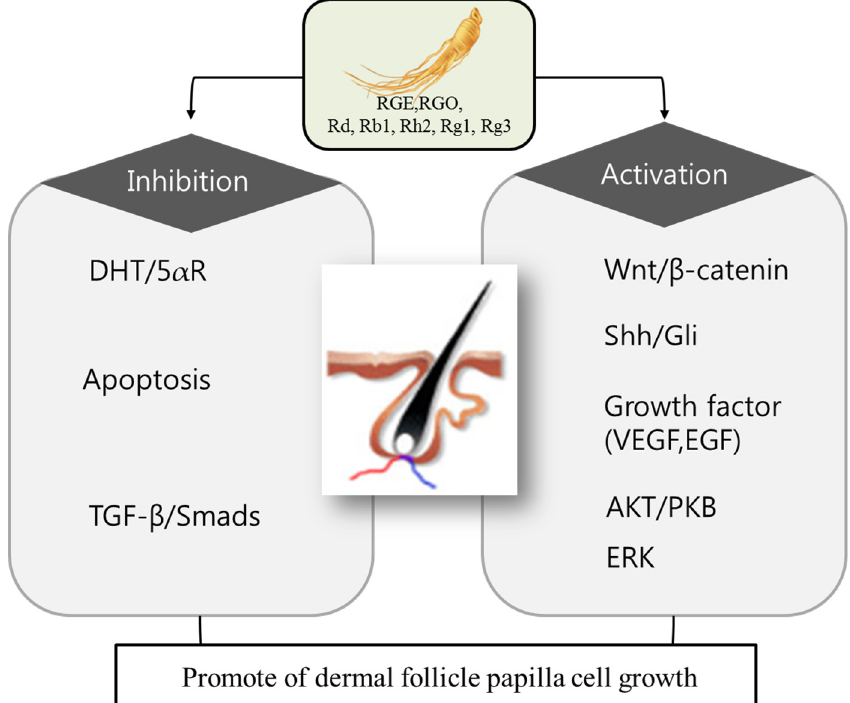
Figure 1. Potential molecular targets of ginseng in hair growth and loss. Ginseng exhibits therapeutic potential for hair growth and preventing hair loss by preventing the apoptosis of dermal follicle papilla cells. Ginseng components: RGE (red ginseng extract), RGO (red ginseng oil), ginsenoside Rd, Rb1, Rh2, Rg1, Rg3. antiandrogenic: DHT (dihydrotestosterone), 5-aR (5α-reductase). Apoptosis inhibition: TGF- β (transforming growth factor beta), Smads (homologues of the Drosophila protein, mothers against decapentaplegic (Mad) and the Caenorhabditis elegan s protein Sma). Proliferation activation: WNT (wingless-type MMTV integration site family member), Shh (Sonic hedgehog), Gli (glioma-associated oncogene homolog), VEGF (vascular endothelial growth factor), EGF (epidermal growth factor), AKT/PKB (protein kinase B), ERK (extracellular-signal-regulated kinases).